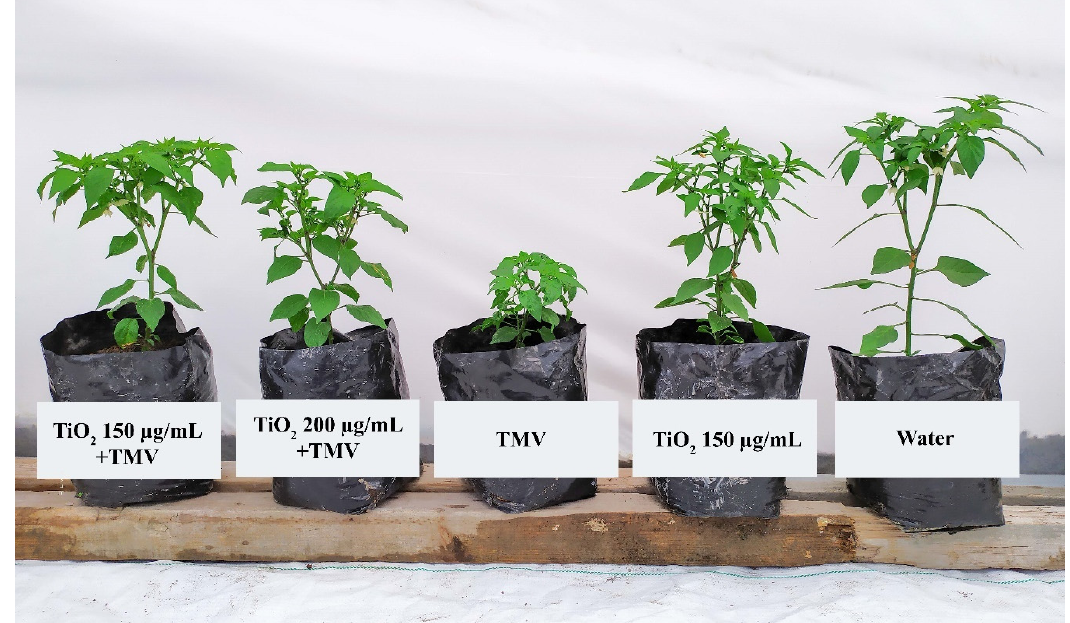
Figure 3. Visual comparison of the plants infected and treated with TiO 2 NPs, TMV-infected plants, plants treated with 150 μ g/mL TiO 2 NPs, and water.